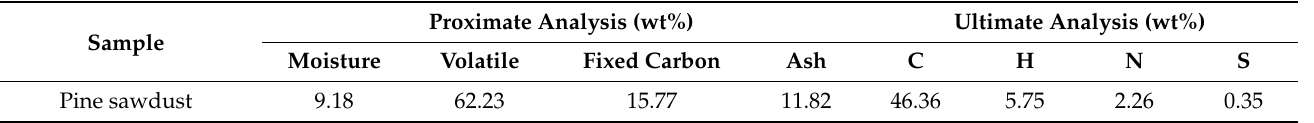
Table 3. The properties of pine sawdust (air-dry